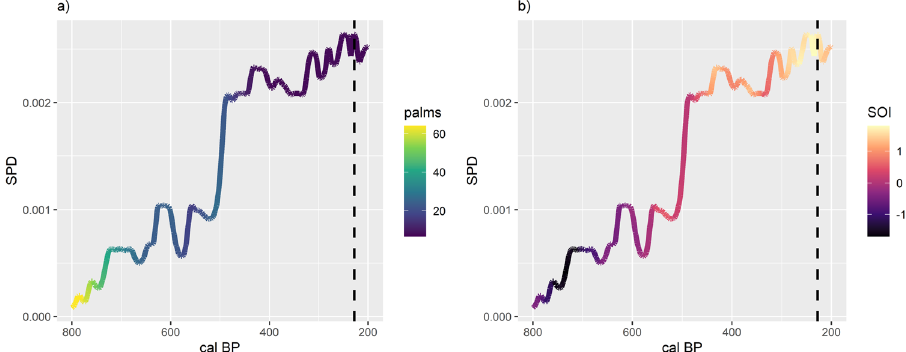
Fig. 2 The observed non-normalized SPD calculated on the basis of 201 class 1 and 2 dates. The color of a shows changes in palm forest cover as measured by palm pollen abundance while the color of b shows changes in SOI. Positive SOI values are associated with drier conditions. The vertical dashed line marks the timing of European contact in AD